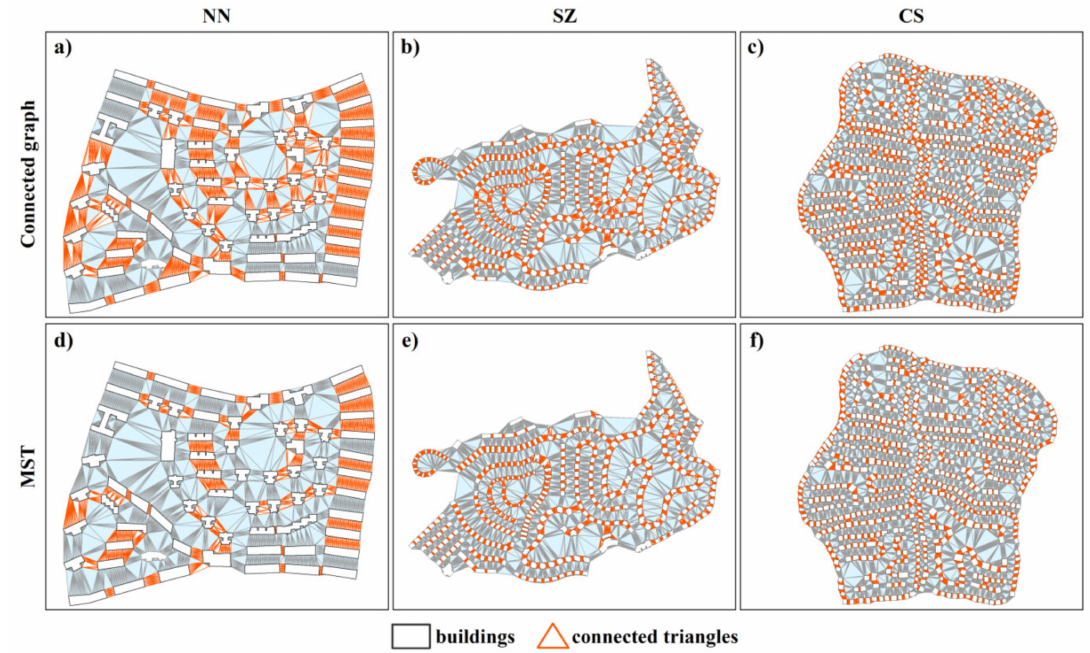
Figure 9. Intermediate results before performing step 6 are shown for ( a )–( c ) the proposed method in three datasets; ( d )–( f ) MST in three